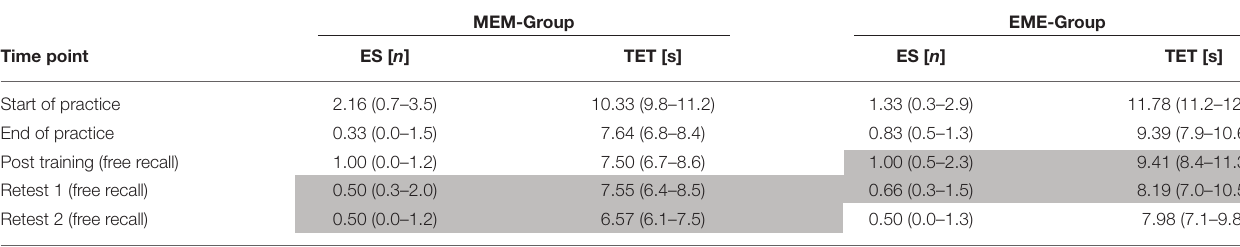
TABLE 1 | Behavioral data: number of Erroneous Sequences (ES) and Total Execution Time (TET) .